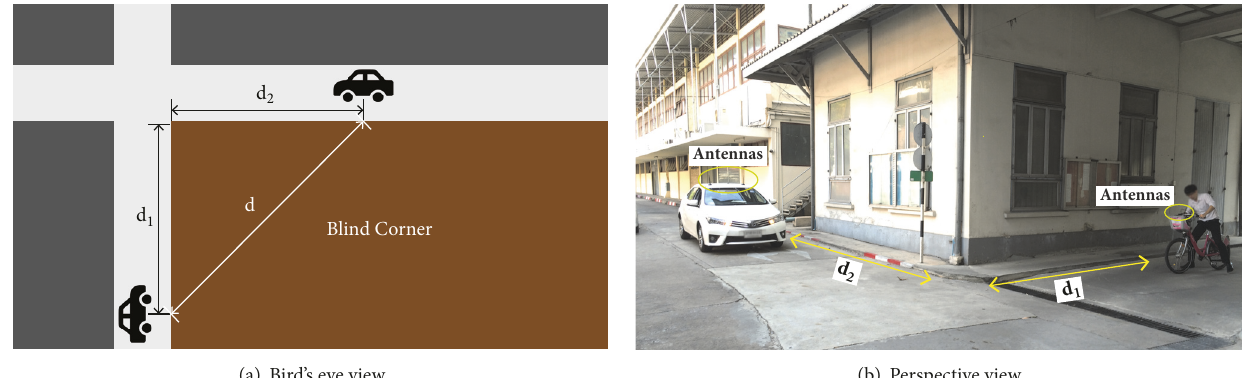
Figure 3: The experiment scenario: (a) bird view and (b) perspective view.